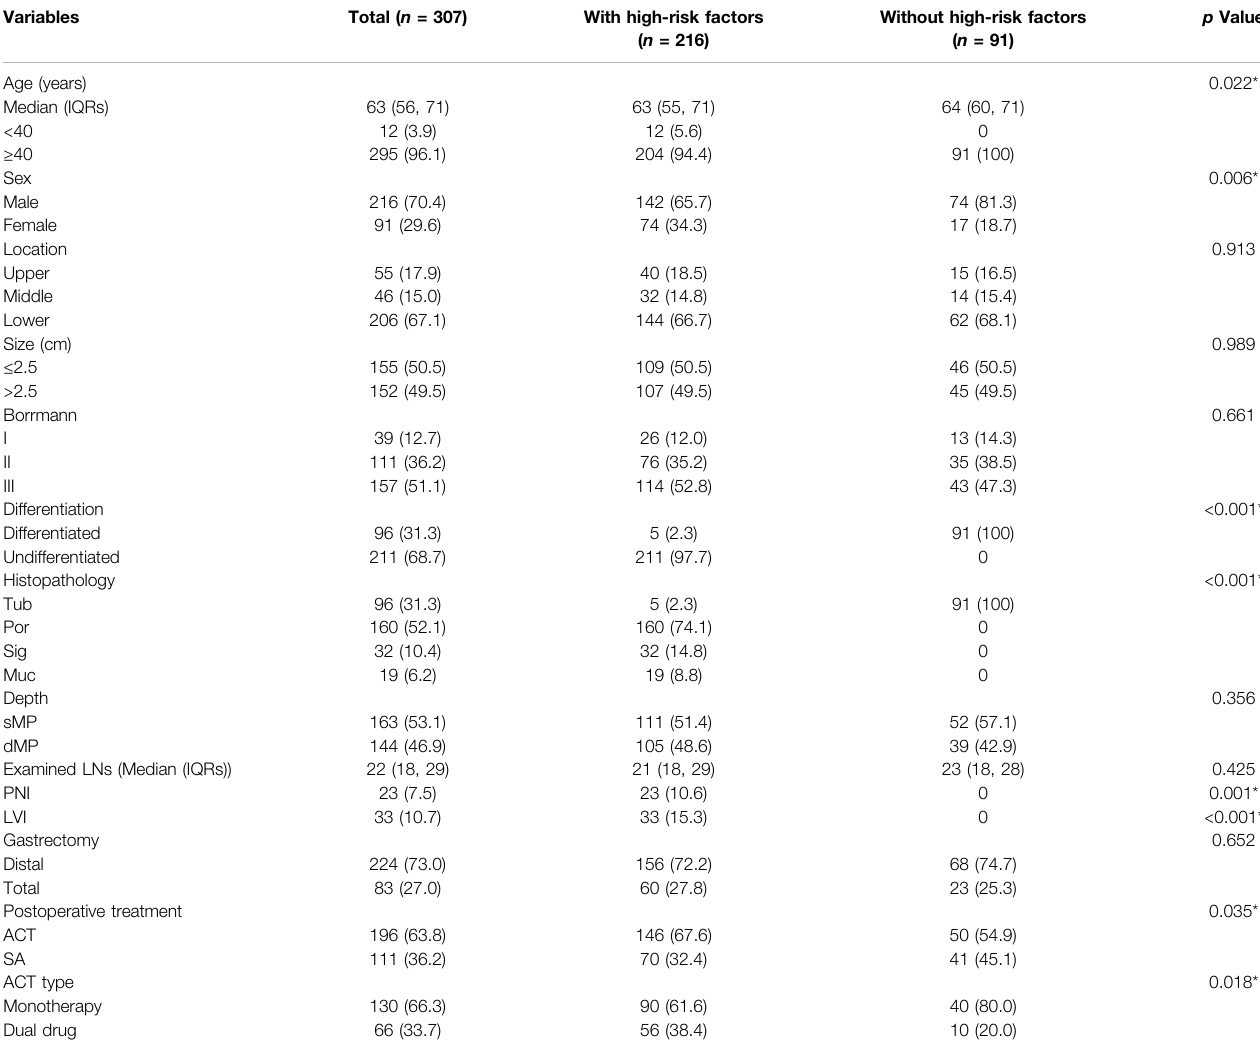
TABLE 1 | Clinical pathological characteristics of patients with pT2N0M0 gastric cancer.